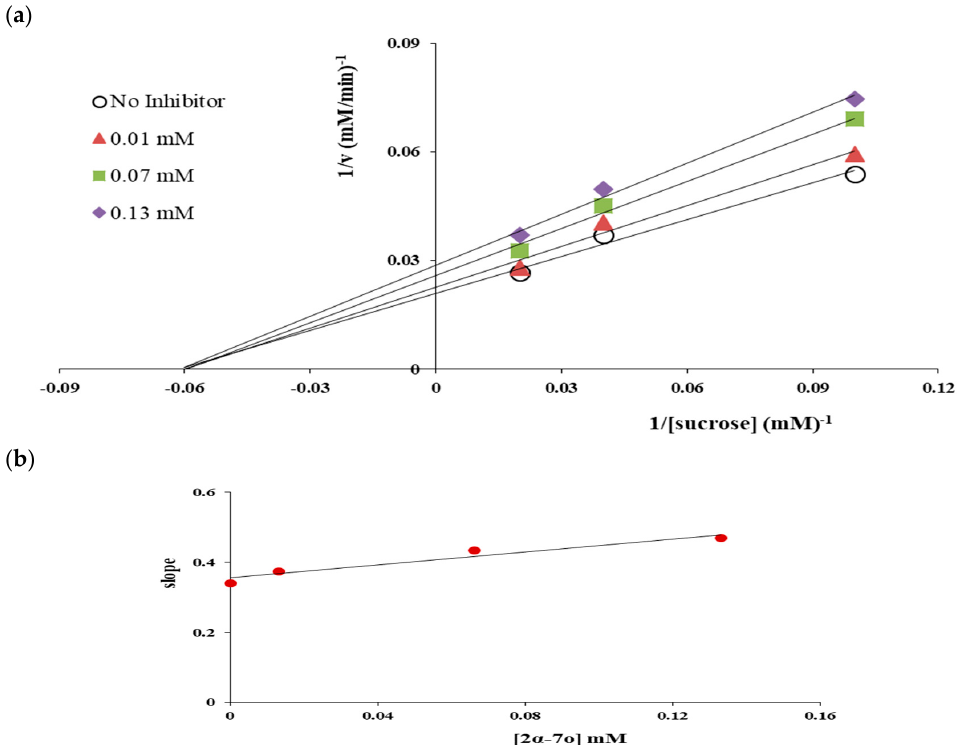
Figure 12. Lineweaver–Burk plots for inhibitory activity of 2 α -7o against rat intestinal sucrase ( a ). Secondary replots of slope vs. [I] ( b ) from a primary Lineweaver–Burk plot for the determination of K i .